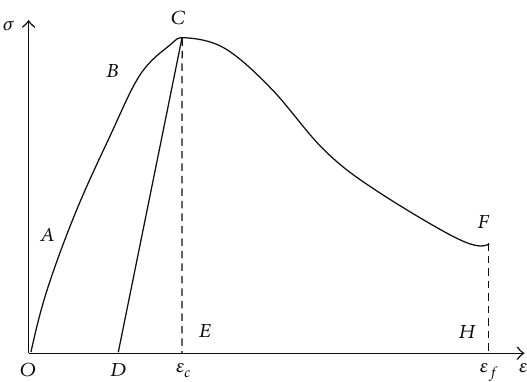
Figure4:Typicalstress-straincurveunderuniaxialcompressionfor rock.